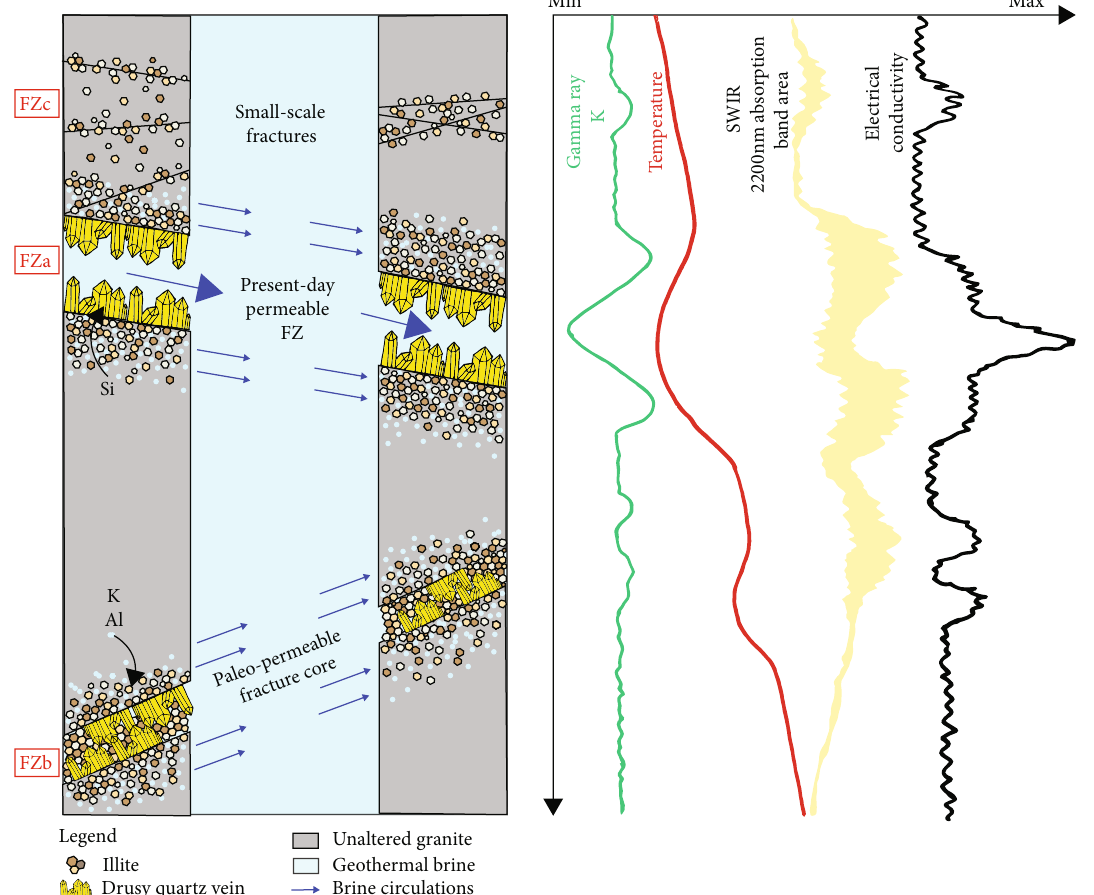
Figure 10: Model showing the variation in the 2200nm absorption band area and its correlation with geophysical logs (gamma ray, temperature, and electrical conductivity) in response to di ff erent grades of hydrothermal alteration of the granite and di ff erent FZ